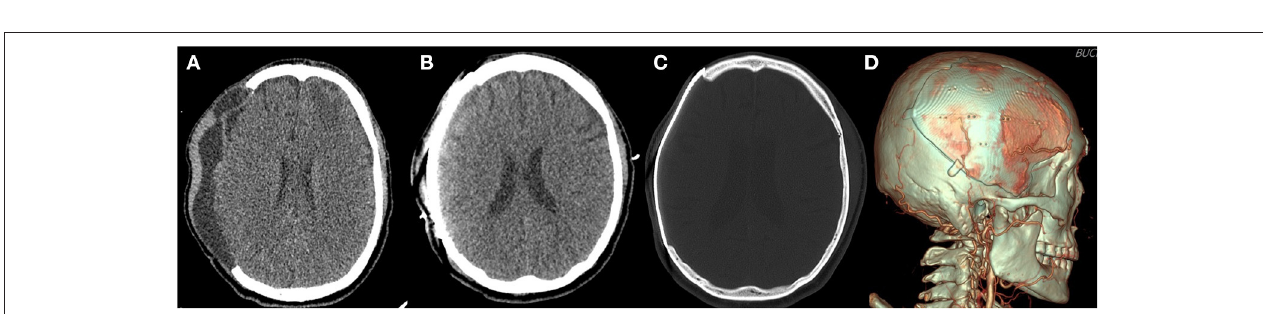
FIGURE 1 | Preoperative and postoperative fluid collections on computed tomography (CT) scans. (A) Subgaleal and epidural fluid collections following decompressive craniectomy on the preoperative CT scan. (B) Subdural fluid collections with hydrocephalus on the preoperative CT scan. (C) Subdural fluid collection on the postoperative CT scan (7 days after cranioplasty). (D) Subgaleal fluid collection on the postoperative CT scan (7 days after cranioplasty).